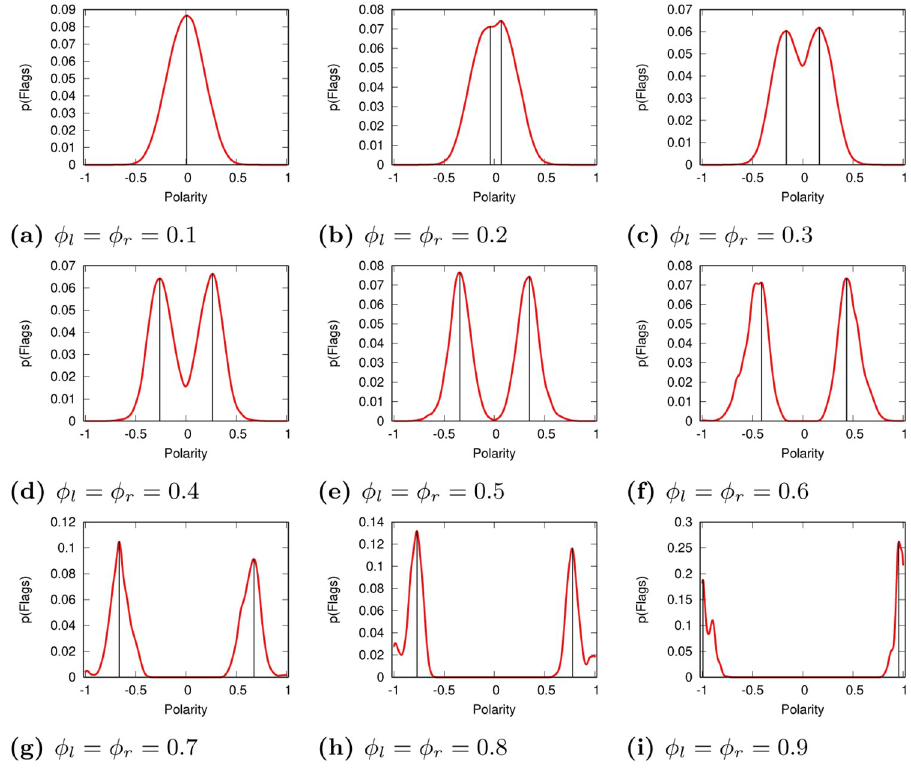
Fig 3. The flag distributions in the Bipolar model for varying levels of tolerance ( ϕ l and ϕ r ). The plot reports the probability that a flag (y axis) will be assigned to a source with a given polarity (x axis). Red lines for KDE estimation, the black thin lines identify the most prominent peaks on the left and the right of zero polarity (if any). (a) ϕ l = ϕ r = 0.1. (b) ϕ = ϕ = 0.2. (c) ϕ = ϕ = 0.3. (d) ϕ = ϕ = 0.4. (e) ϕ = ϕ = 0.5. (f) ϕ = ϕ = 0.6. (g) ϕ = ϕ = 0.7. (h) ϕ = ϕ = 0.8. (i) l r l r l r l r l r l r l r ϕ l = ϕ r =